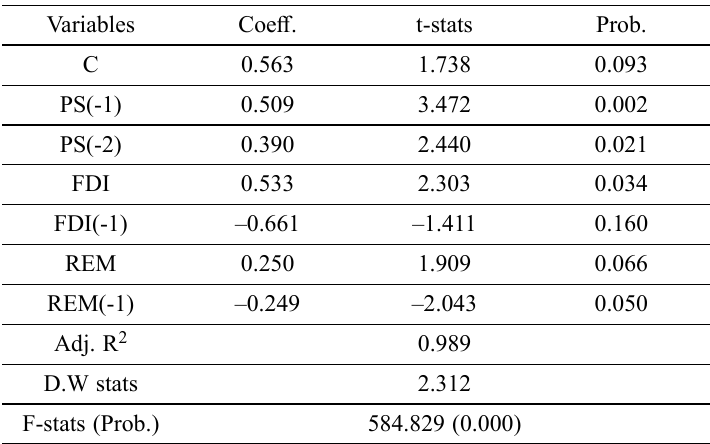
Table 5. Long run results using ARDL